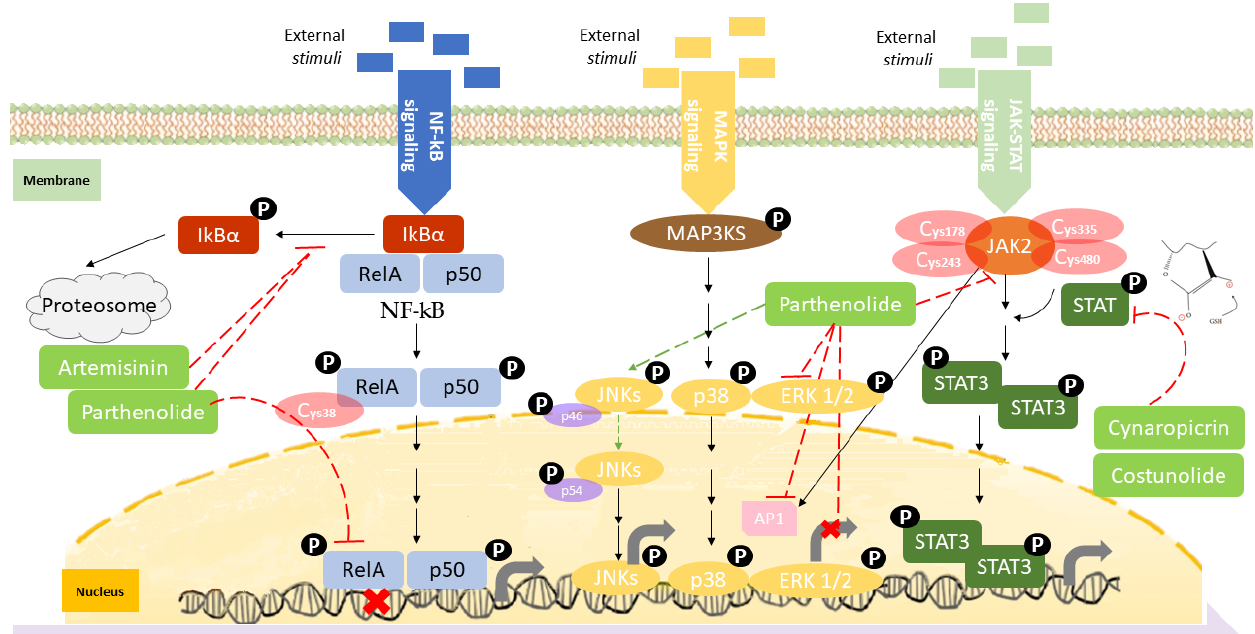
Figure 3. Overview of the three major signaling pathways regulating inflammation: NF-kB, MAPK, and JAK-STAT. Few sesquiterpene lactones are presented as examples to demonstrate their inhibitory action within the different molecular mechanisms.